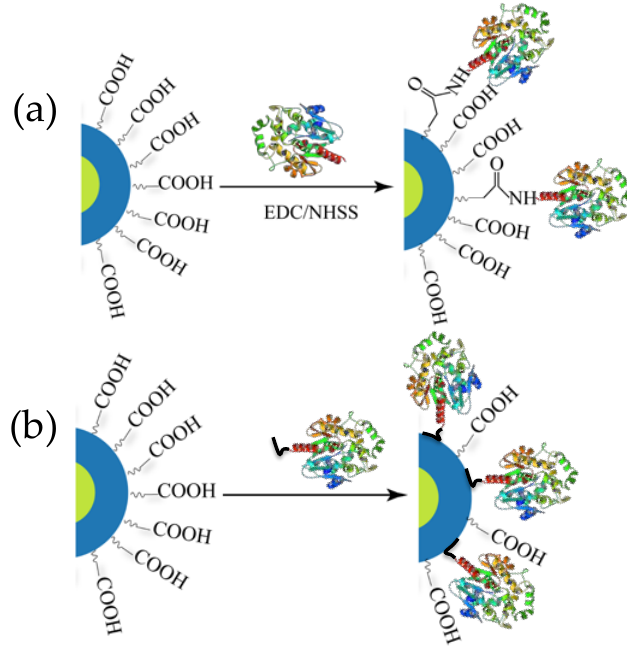
Figure 2. Schematic depicting two major ways of conjugating luciferase to QDs. ( a ) Chemical conjugation via 1-ethyl-3-(3-dimethulaminopropyl)carbodiimide (EDC) coupling chemistry. ( b ) Spontaneous self-assembly via His 6 mediated metal affinity coordination where the imidazole side chain of His residues binds to the Zn 2+ of the ZnS shell of the QD. His 6 motifs are usually recombinantly inserted to one end of the enzyme for purification of Ni 2+ chelate media.